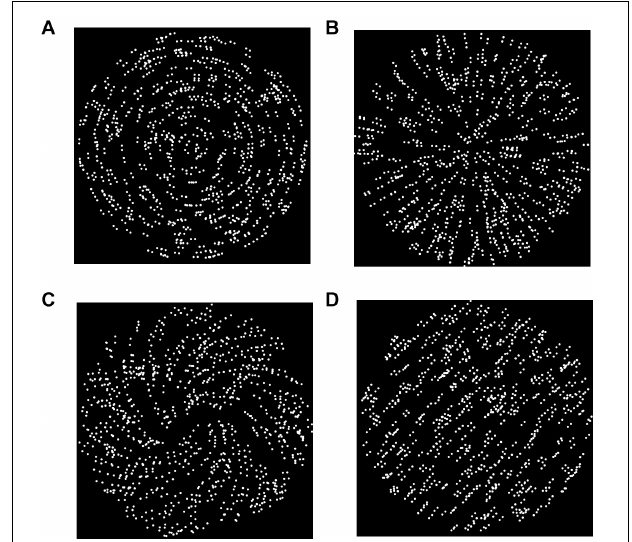
FIGURE 2 | Common types of static GPs used in studies that investigate the neural basis of form and motion interaction. (A) Circular GP; (B) radial GP; (C) spiral GP; (D) translational/parallel